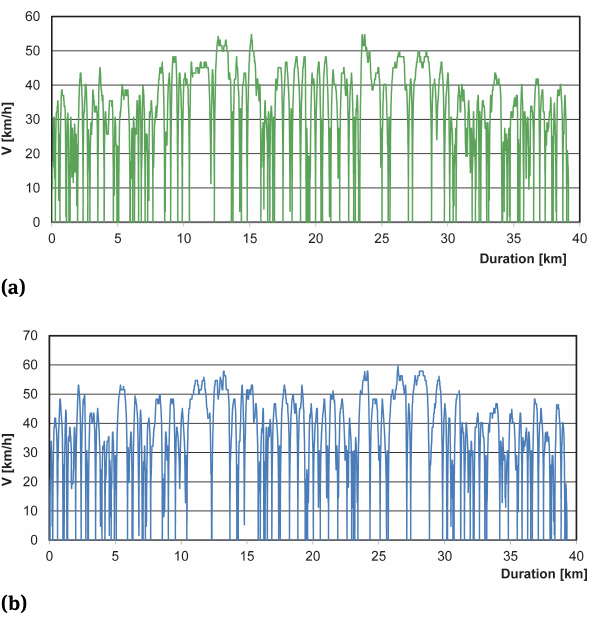
Figure 3: Speed profile and route diagram for road emission